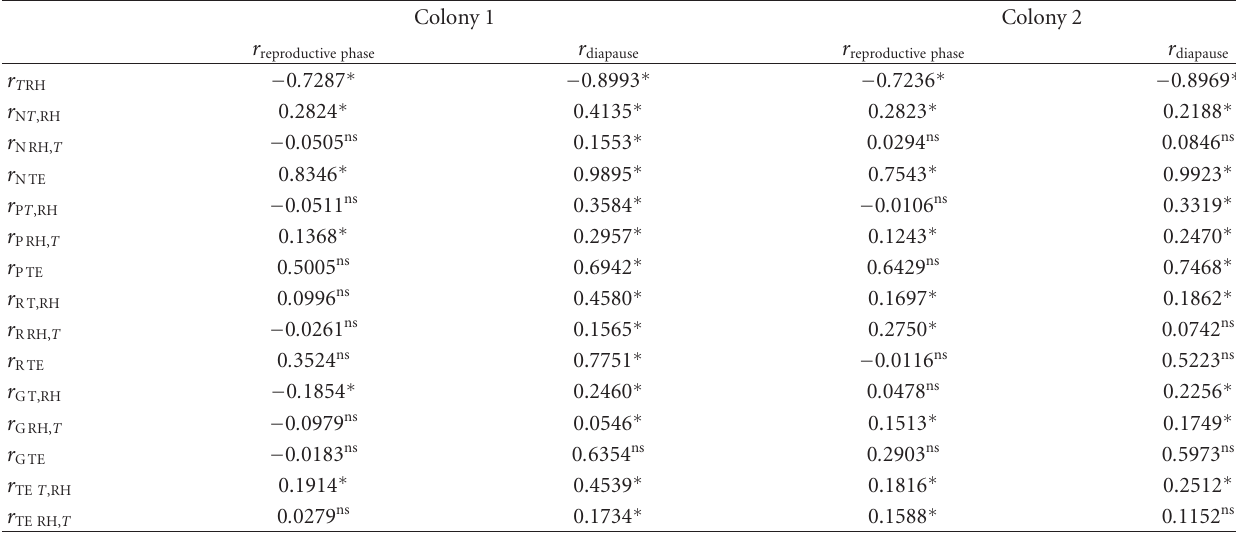
Table 2: Partial correlations ( r ab , c , where a and b are the correlated variables and c the controlled variable) between nectar (N), pollen (P), resin (R), garbage (G), and total number of incoming trips (TE) and temperature ( T ) and relative humidity (RH); and Spearman correlations ( r ab , where a and b are the correlated variables) between temperature ( T ) and relative humidity (RH), and between nectar (N), pollen (P), resin (R), garbage (G), and total number of incoming trips (TE) in the reproductive phase and in the diapause, in colonies 1 and 2 of Plebeia remota .